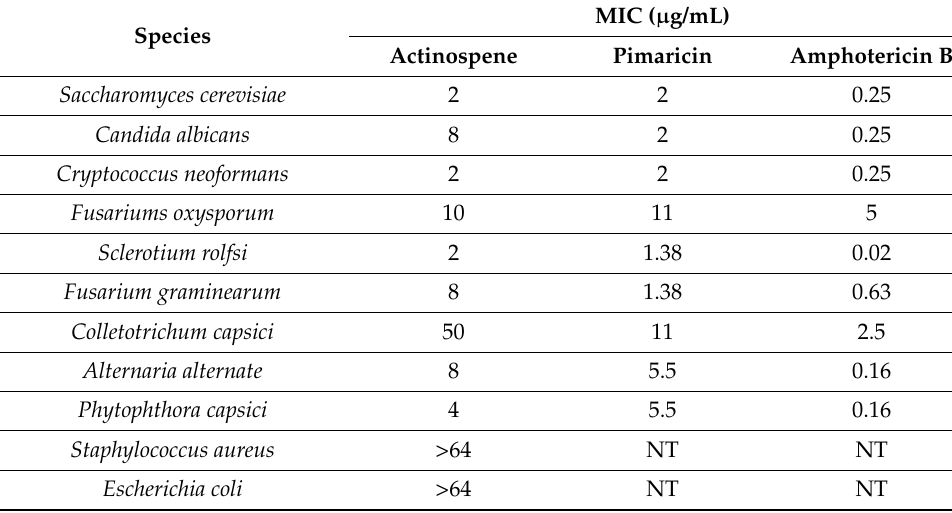
Table 2. MICs of Actinospene (1) against pathogenic fungi and